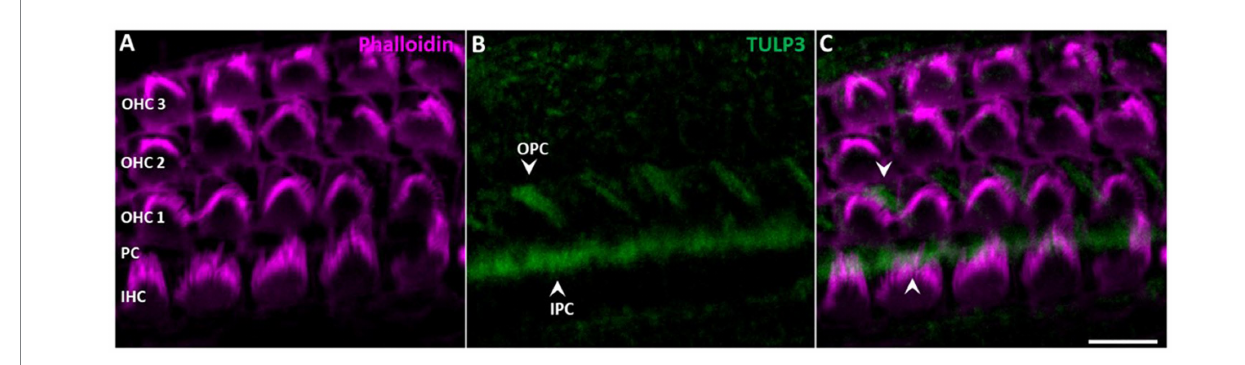
FIGURE 4 TULP3 immunoreactivity in the cochlear epithelium of P3 mice. (A – C) P3 whole-mount immunohistochemical staining of TULP3 (green) and Phalloidin (staining actin, magenta) in the mouse organ of corti. TULP3 immunoreactivity in the outer (OPC) and inner pillar cells (IPC, arrowheads) in the Scale Bar 10 μ m.